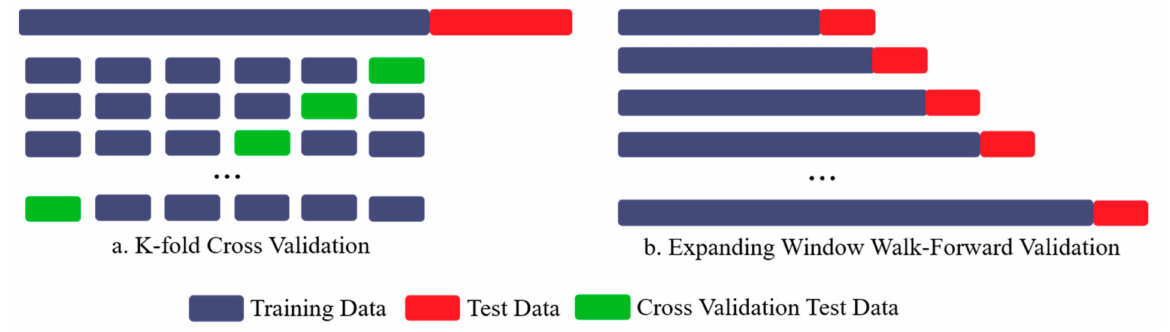
Figure 2. ( a ) Standard K-fold cross validation (Kf-CV) model with training and test data folded into randomly shuffled subsets and hold-out test data for model evaluation ( b ) Walk-forward Validation (WFVal) scheme with adaptive training windows that expand after each iteration to include recent